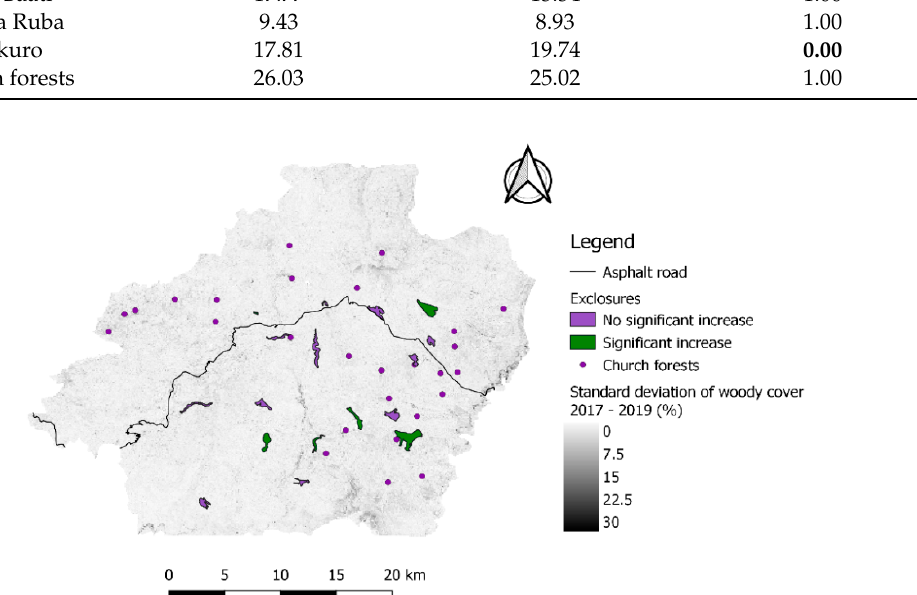
Figure A4. Standard deviation between predicted woody cover from the period 2017 to 2019, together with the location of the 17 exclosures and 25 church forests included in the analysis.